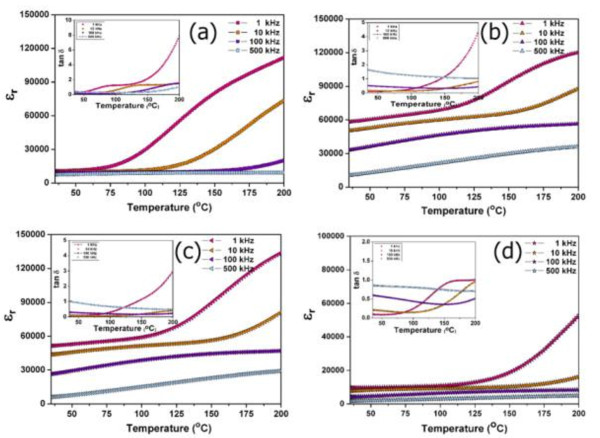
Temperature dependence of the dielectric dispersion at various frequencies. (a) CC3.1TO, (b) CC3.1TO with 0.5 vol.% Al2O3, (c) CC3.1TO with 1 vol.% Al2O3, and (d) CC3.1TO with 2 vol.% Al2O3.